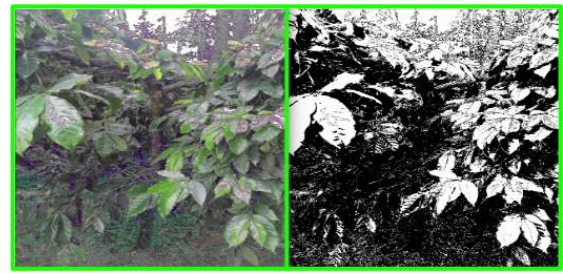
Figure 2. Healthy Plants. Image is prominently filled with white leaf shaped patches